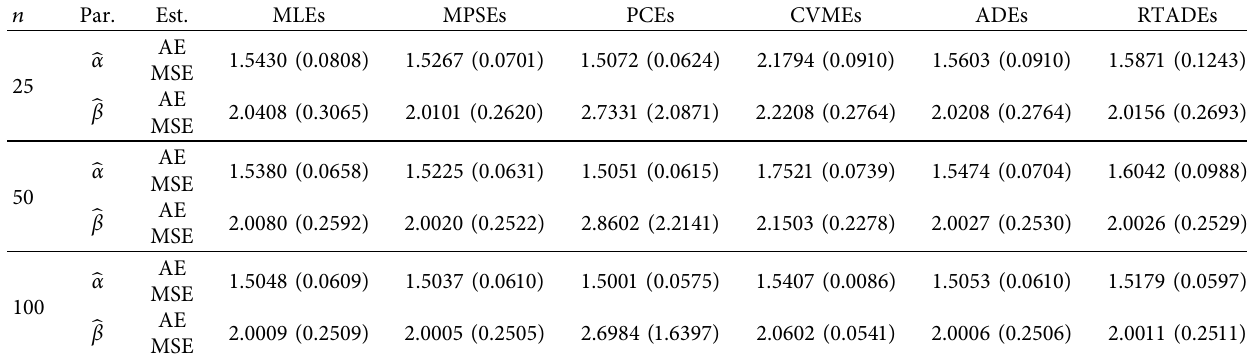
Table 4: The AEs and MSEs for ( α � 1 . 5 and β � 2 . 0 ) T .